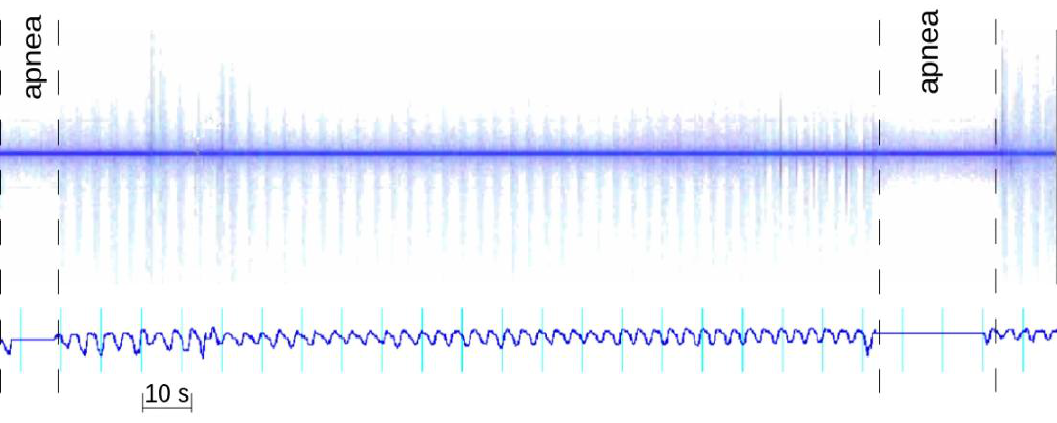
Figure 15. Correspondence between the received spectrum and a nasal cannula